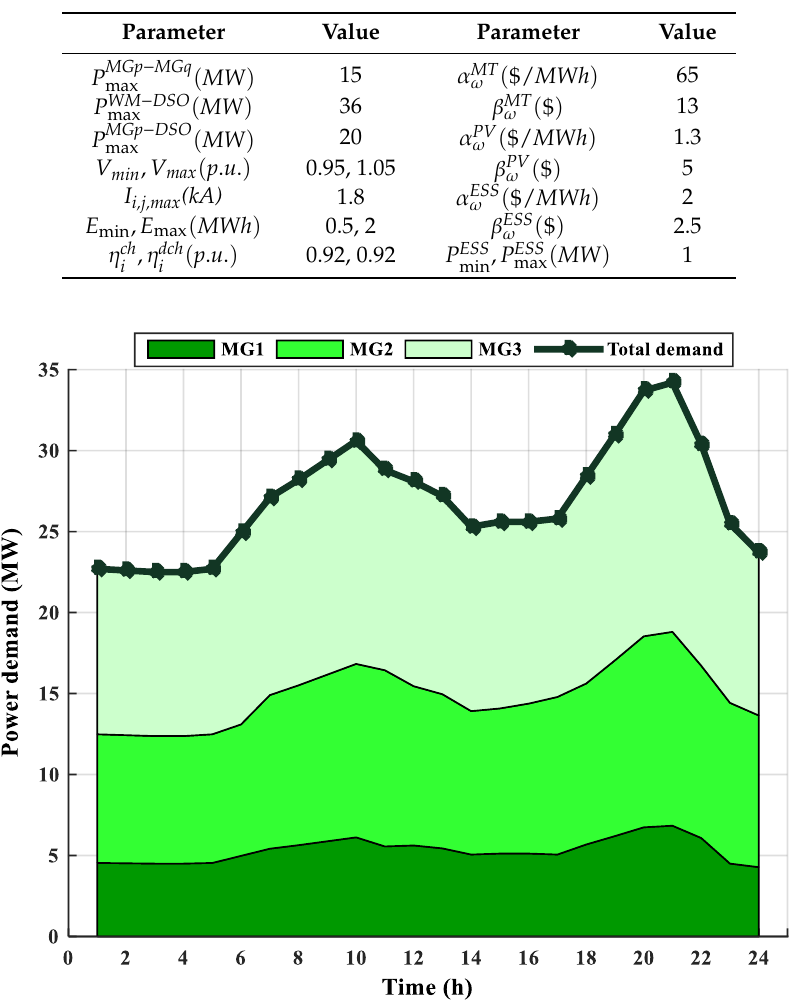
Figure 4. Load profile of each microgrid (MG) and total demand [1].